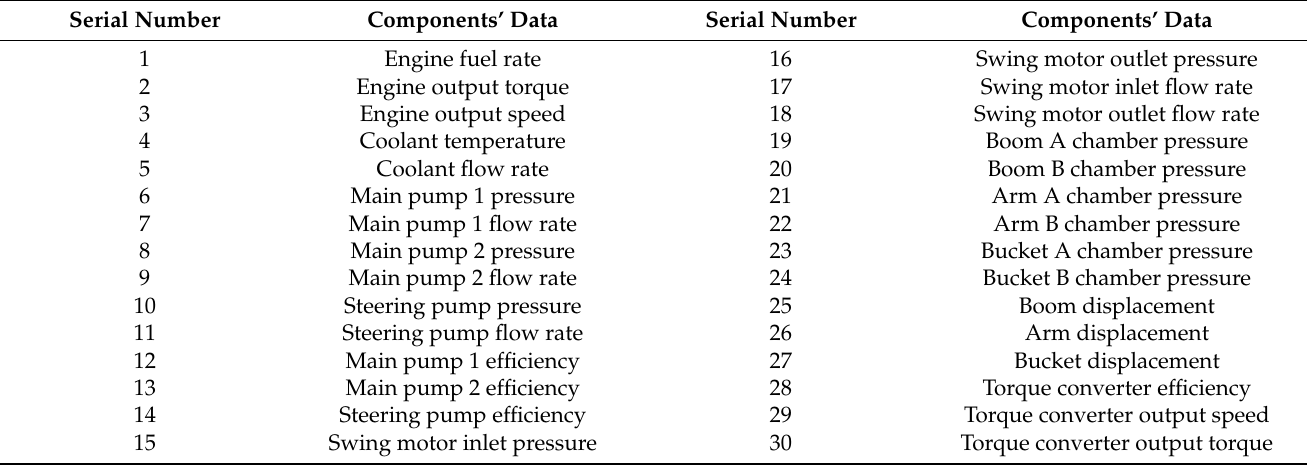
Table 1. Data requirements of components for the excavator energy flow analysis.